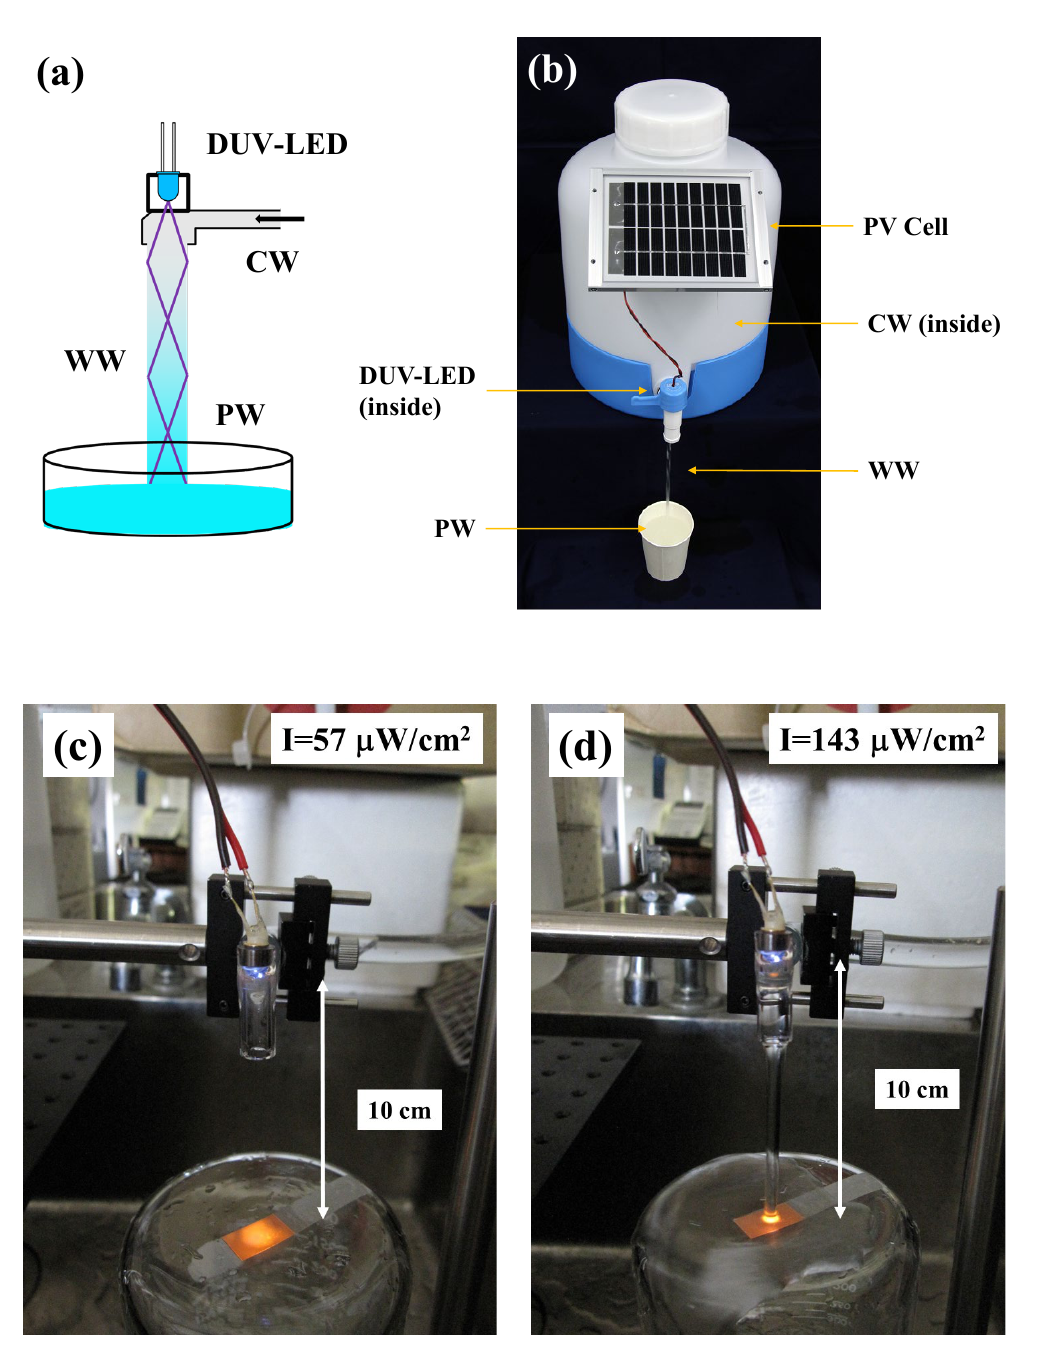
Figure 2. WW disinfection system and the enhancement of the DUV light intensity due to internal reflection in the water flow. ( a ) Schematic of the experimental setup for the WW system [9]. ( b ) WW disinfection system with a PV cell [9]. Demonstration of the DUV light intensity ( c ) without and ( d ) with internal reflection in the water flow by illuminating a phosphor tape [8].